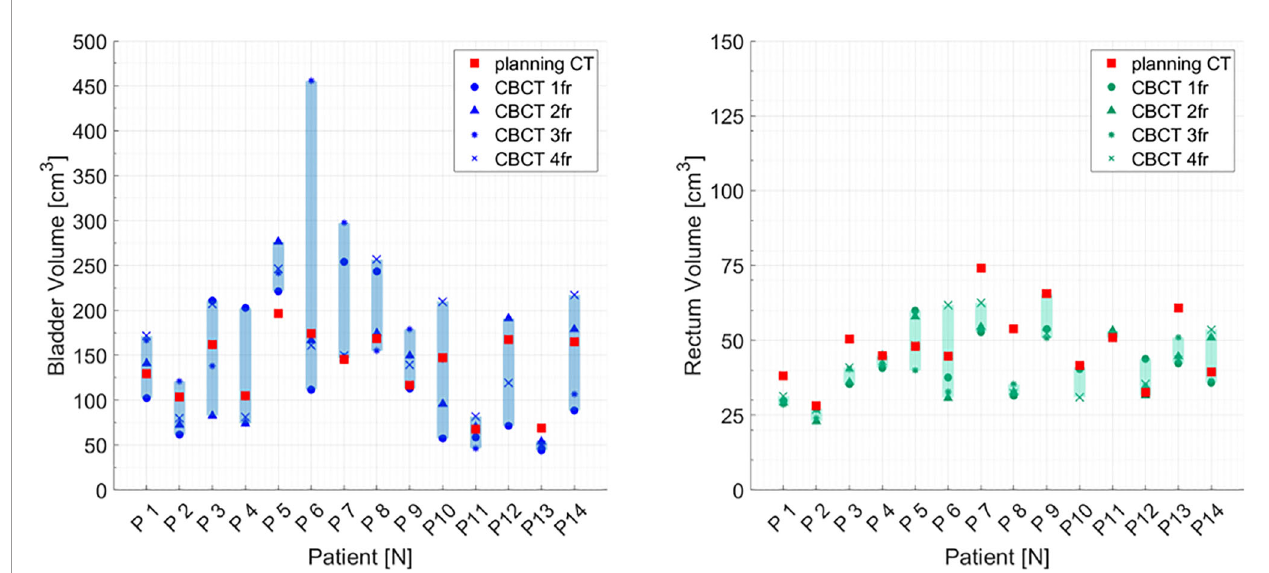
FIGURE 3 | Bladder and rectum volume at planning CT (red squares) and at each cone beam CT (dark symbols) for all the patients separately. Graphical shades indicate the extent of volume